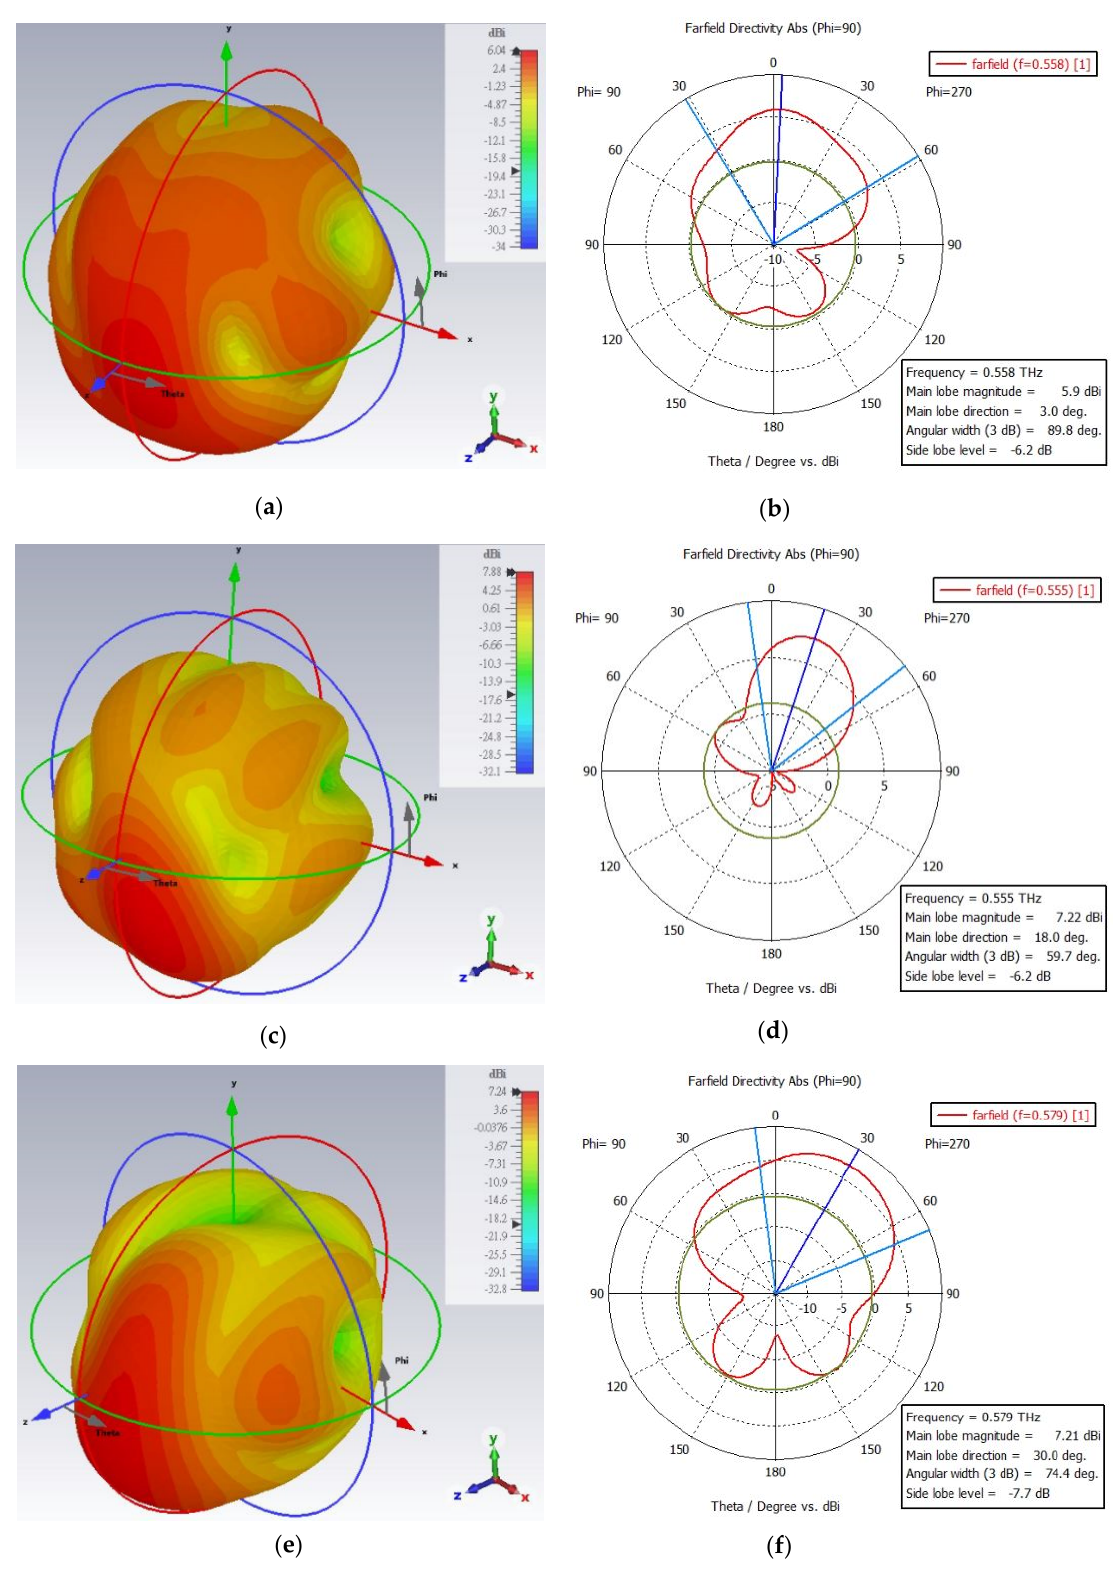
Figure 6. The 3D and polar plot of the farfield radiation pattern of the one segment Hilbert fractal reconfigurable antenna from ( a , b ) ordinary (at 0.54 THz) to ( c , d ) extraordinary (at 0.504 THz) po- larization in the PDLC.